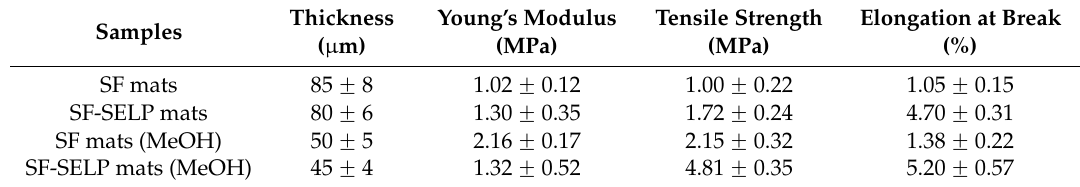
Table 3. The average thickness, Young’s moduli, tensile strength and elongation at break of SF fibers mats and SF-SELP core-shell fibers mats (sample size N =